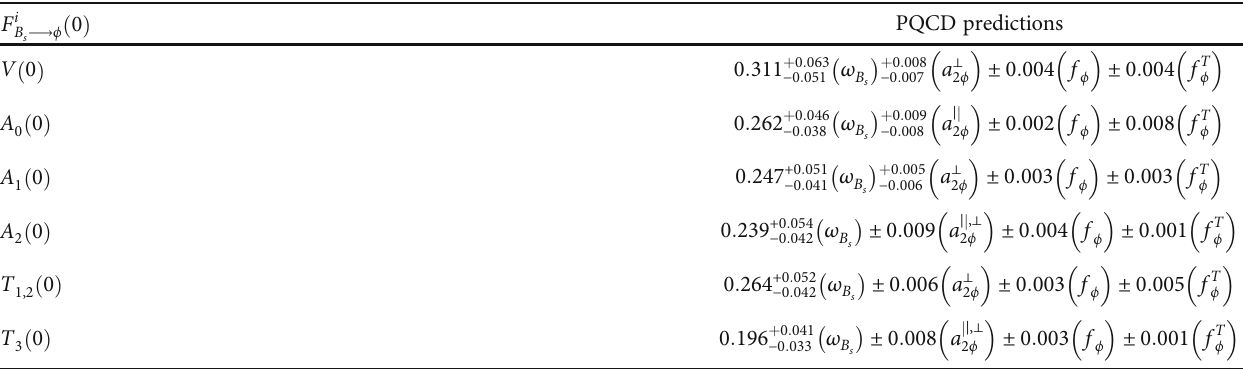
Table 2: The PQCD predictions of the seven form factors F i ∣ j , ⊥ ω T , a 2 ϕ , f ϕ , and f ϕ . B s